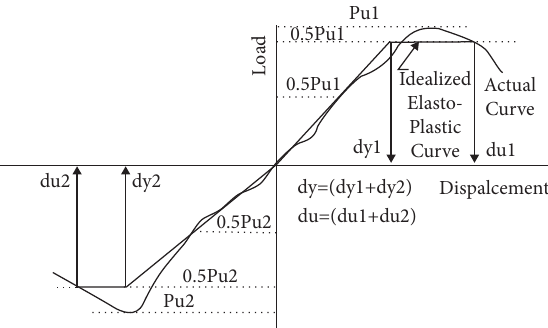
Figure 15: Method used to define the yield and ultimate displacements [30].